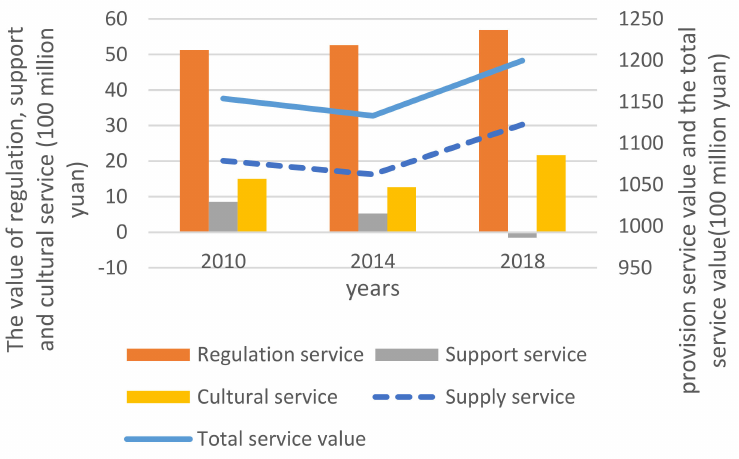
Figure 8. Comparison of the service value of Taihu Lake water ecosystem from 2010 to